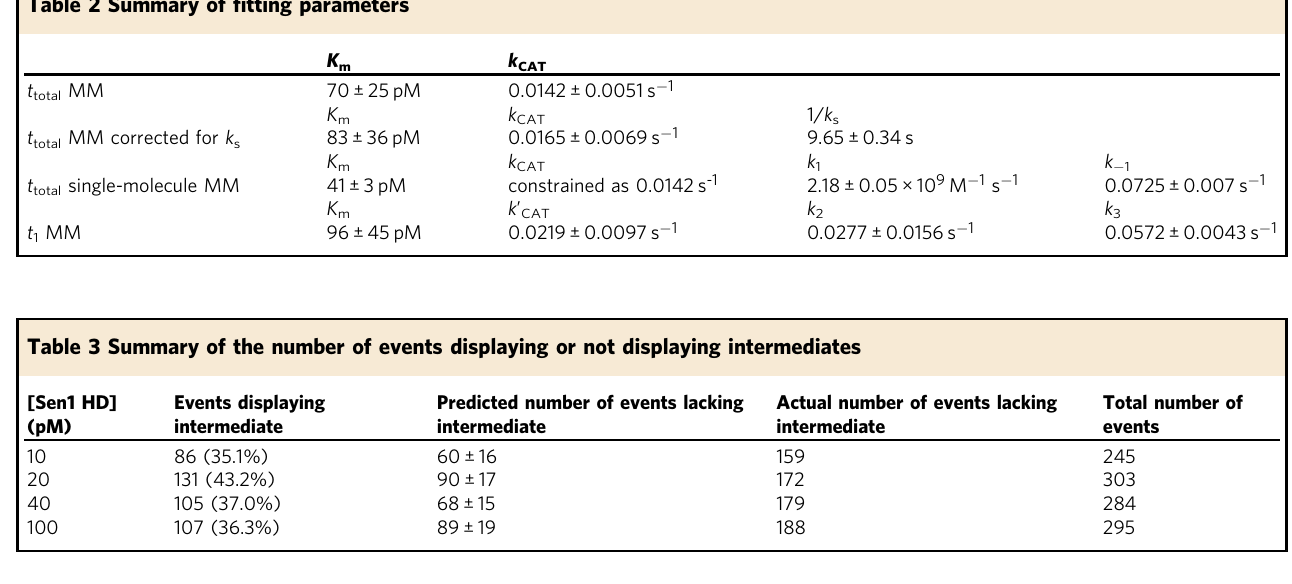
Table 2 Summary of fi tting